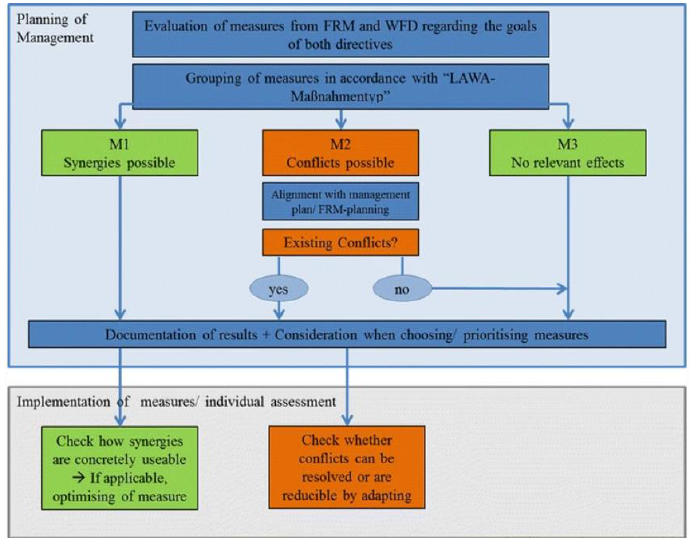
Figure 9. Management plan for IRBM